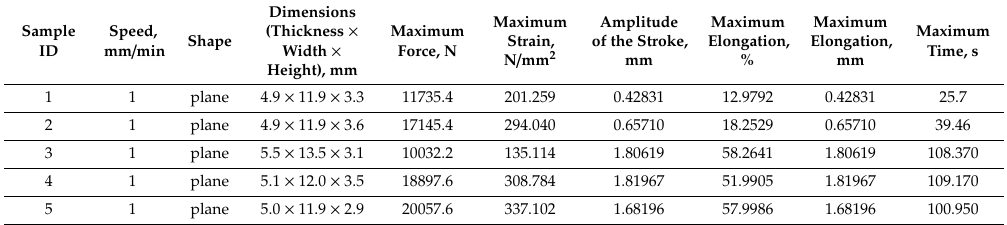
Figure 15. Strength tests of samples of compacted SiO 2 nanopowder: ( a ) Shimadzu tester; ( b ) sample of compacted nanopowder; ( c ) sample before test. Table 8. Characteristics of compacted SiO 2 nanopowder samples during compressive strength tests.